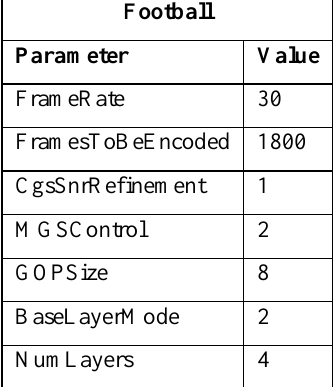
Table 1. Encoder